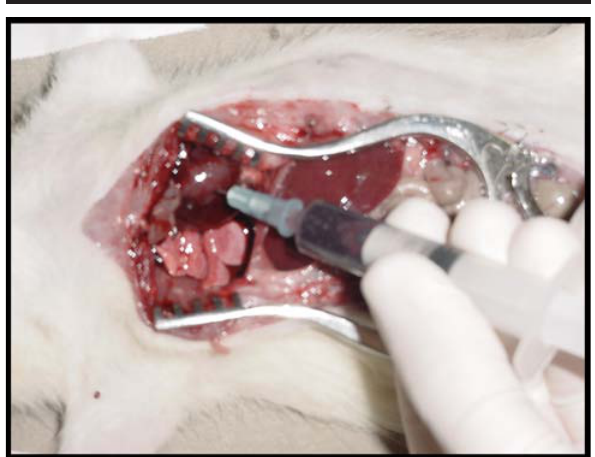
FIGURE 5 - Intracardiac puncture on anesthetized animal.